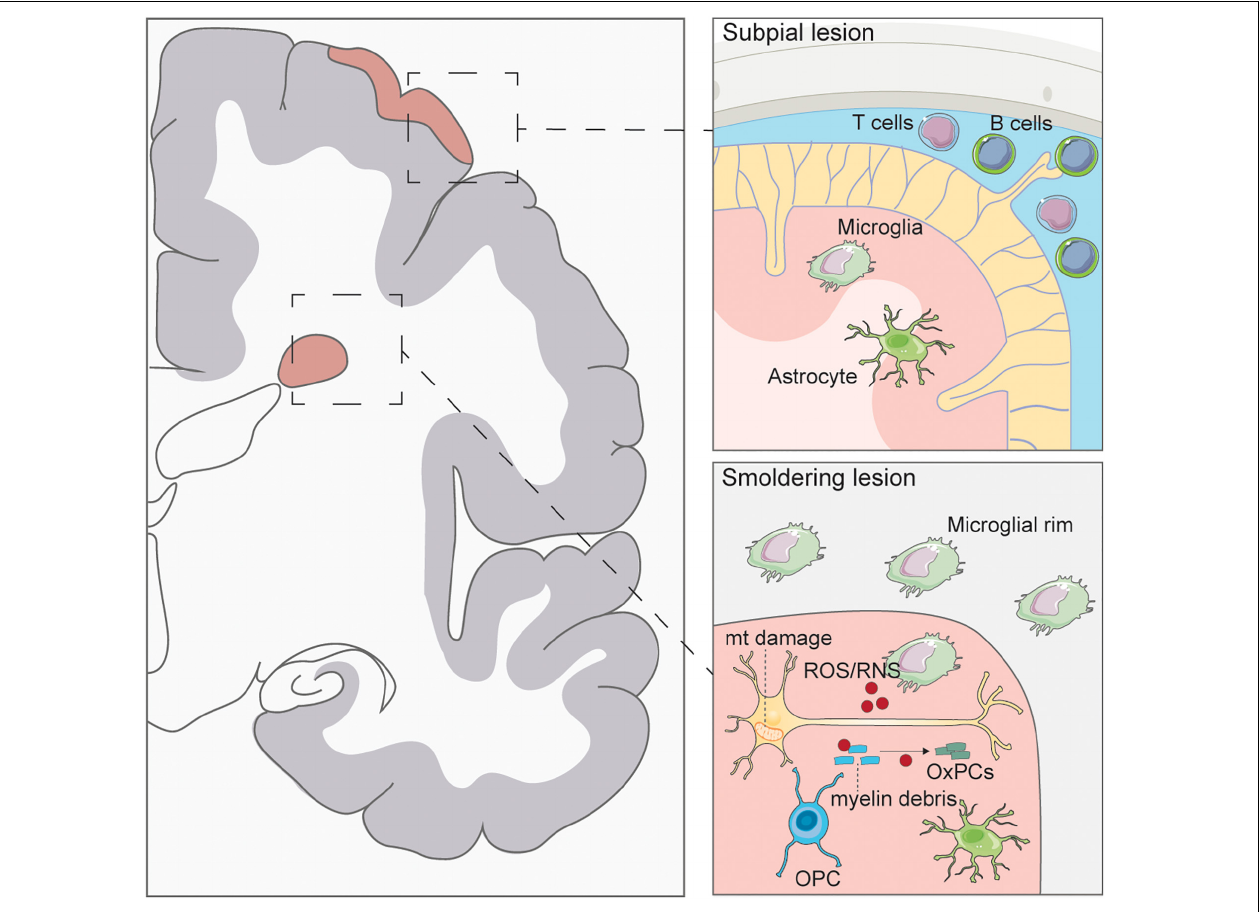
FIGURE 1 | Pathology of progressive multiple sclerosis. Subpial lesions are typically found in PMS which are characterized by lymphocyte accumulation in the meninges. Activated T and B cells can secrete inflammatory cytokines causing microglia and astrocyte activation and ensuing demyelination of the cortex. Smoldering lesions are characterized by the degeneration of demyelinated neurons and surrounding microglial rim. Demyelinated axons have been found to have mitochondrial (mt) damage caused by ROS/RNS secretion from activated microglia. ROS/RNS can also oxidize myelin debris to generate oxidized phosphatidylcholines (OxPCs), which are toxic to neurons. Few oligodendrocyte progenitor cells (OPCs) are seen in these lesions, with no